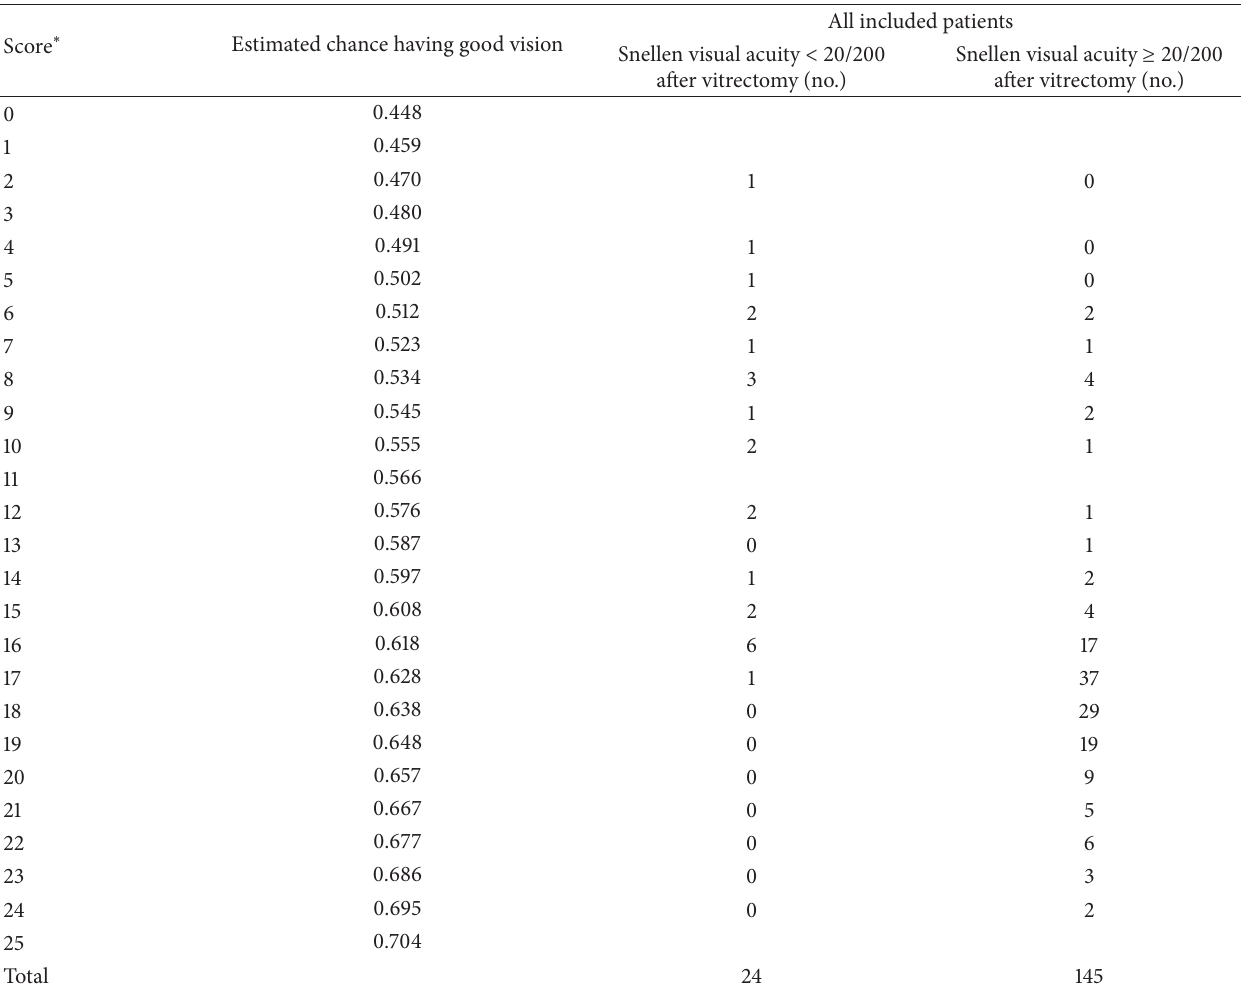
Table 5: Risk scores of study patients with acute-onset vitreous hemorrhage (VH) of preoperatively unknown origin. Score ∗ Estimated chance having good vision